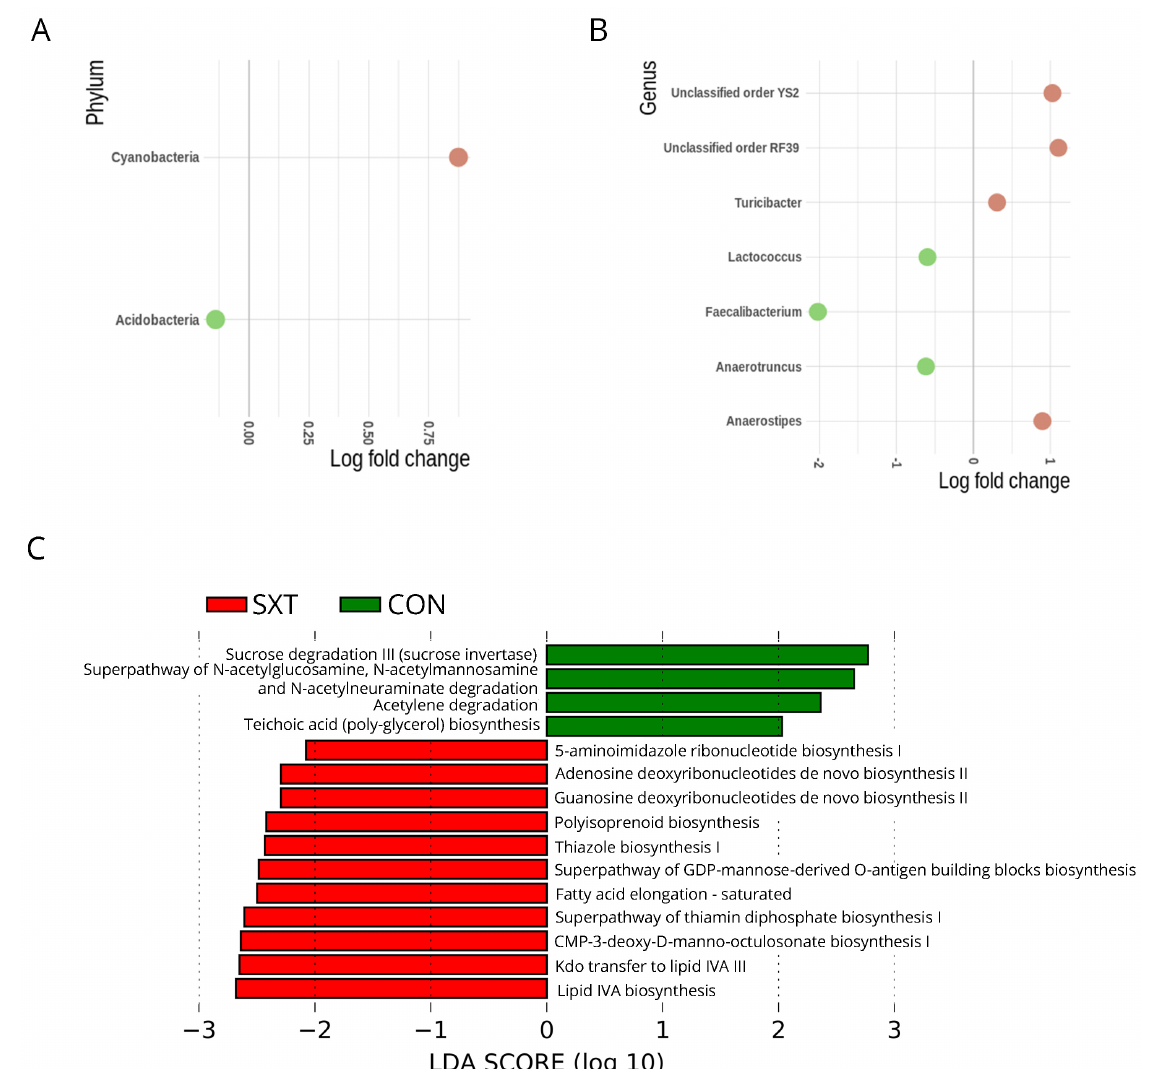
Figure 4. The gut microbiota composition and inferred functional content of gut microbiota between control (CON) and cotrimoxazole (SXT) C57BL/6 mice. ( A ) ANCOM-BC log fold change showing differentially abundant taxonomic phylum in the gut microbiota of SXT (n = 6) versus CON (n = 6) C57BL/6 mice; ( B ) ANCOM-BC log fold change showing differentially abundant taxonomic genus in the gut microbiota of SXT (n = 6) versus CON (n = 6) C57BL/6 mice; ( C ) LEfSe LDA scores showing significant pathway differences between CON (n = 6) and SXT (n = 6) C57BL/6 mice of PICRUSt predicted the relative MetaCyc pathways abundances. Significant differences between groups were corrected with Benjamini–Hochberg False Discovery Rate p FDR < 0.05.